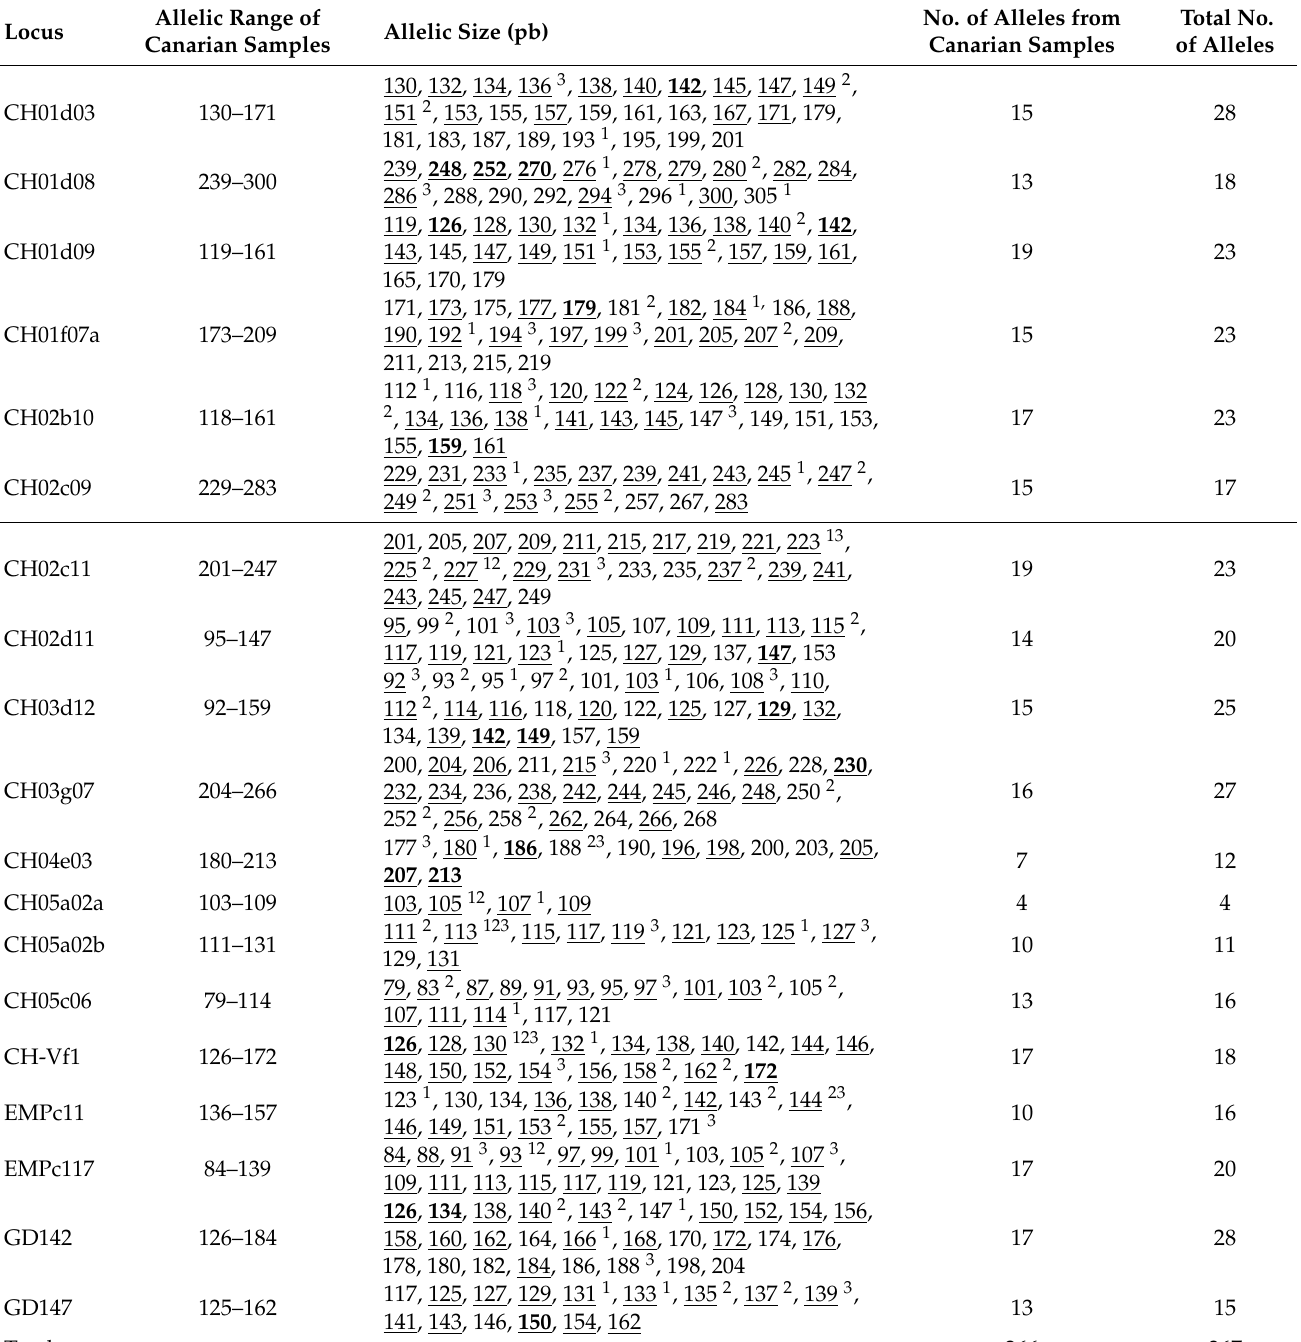
Table 1. Ranges and allelic sizes (pb) for 19 polymorphic loci in the entries studied. The alleles located in the Canarian samples are underlined and those found only in this region are highlighted in